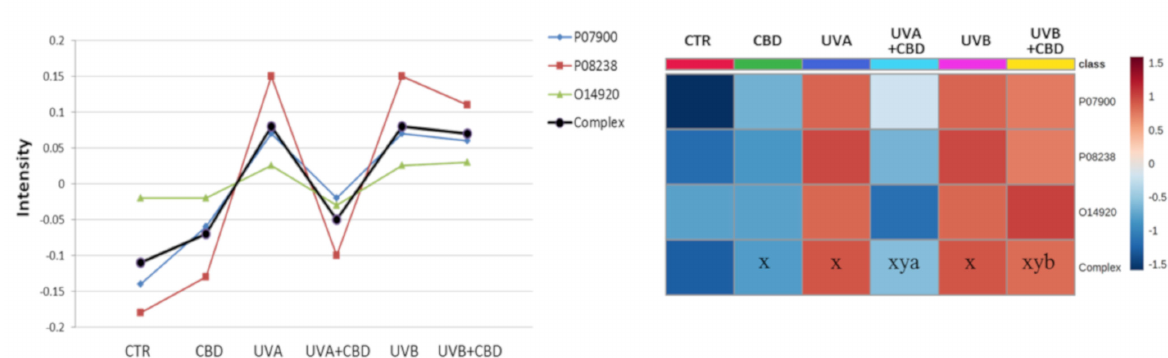
Figure 4. The point graph and heatmap showing the average intensity of proteins creating TNF α /NF κ B ( A ) and I κ BKB/HSP90 ( B ) complexes in keratinocytes following UVA (30 J/cm 2 ) or UVB (60 mJ/cm 2 ) radiation and treated with cannabidiol (CBD, 4 µ M) in a three-dimensional culture model. Proteins IDs: O14920, inhibitor of nuclear factor κ -B kinase subunit B; P01375, tumor necrosis factor α ; P07900, heat shock protein HSP 90A; P08238, heat shock protein HSP 90B; P19838, nuclear factor NF κ B p105; P62888, 60S ribosomal protein L30; Q02878, 60S ribosomal protein L6; Q8N163, cell cycle and apoptosis regulator protein 2. Statistical significances showed only for the whole complexes. X: statistically significant differences vs. non-treated cells, p < 0.05; y: statistically significant differences vs. CBD-treated cells, p < 0.05; a: statistically significant differences vs. UVA-irradiated cells, p < 0.05; b: statistically significant differences vs. UVB-irradiated cells, p <